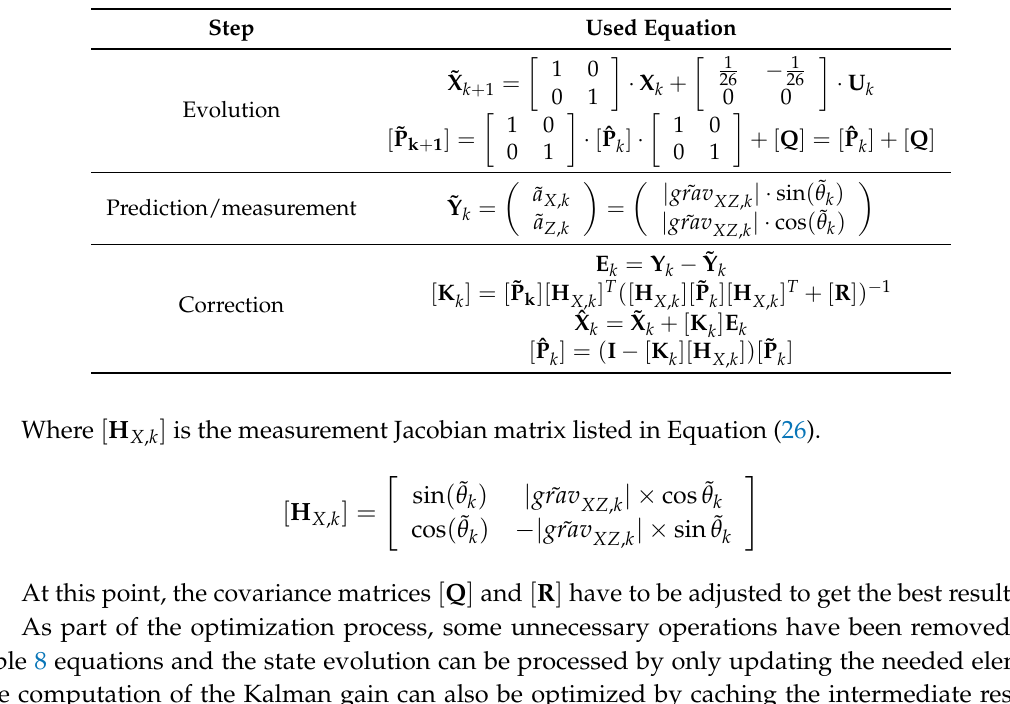
Table 8. Filter applied to Estimation Mode.